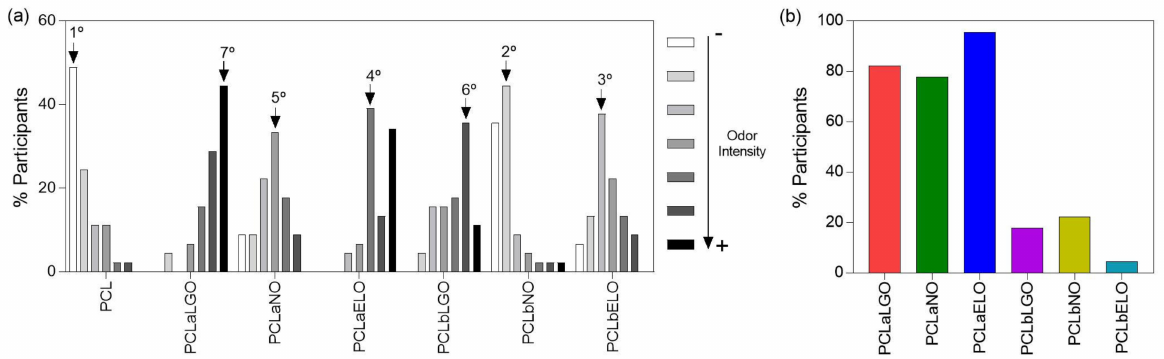
Figure 3. ( a ) Classification of the mats based on their odor intensity level. Participants were required to select one mat for each level of intensity (100% participation per level). Highest classifications for each mat are identified with an arrow and ranking position. ( b ) Discriminatory evaluation between mats modified with the same oil via different loading strategies (PCLaEOs vs PCLbEOs).